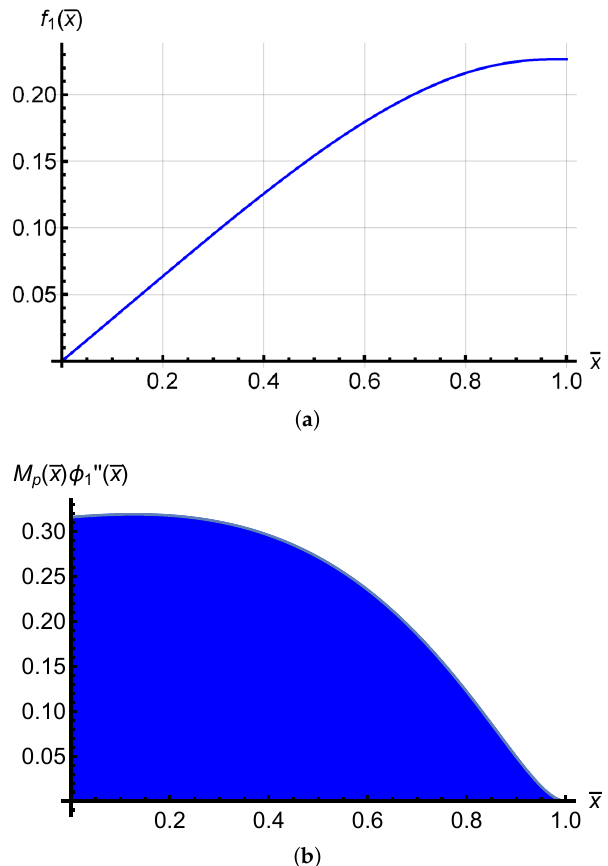
( ¯ x ) . The first mode excitation and Figure 4. ( a ) function f 1 ( ¯ x ) , ( b ) graph of the integrand M p ( ¯ x ) φ (cid:48)(cid:48) 1 c = 5 were considered. The O.V.D. provided no voltage sign change, since the minimum of f 1 ( ¯ x ) coincided with ¯ x = 0, while the maximum was at ¯ x = 1. The same result could be obtained by ( ¯ x ) . The area of this function was always above the x -axis, observing the area subtended by M p ( ¯ x ) φ (cid:48)(cid:48) 1 so no voltage sign change was expected for the first mode.